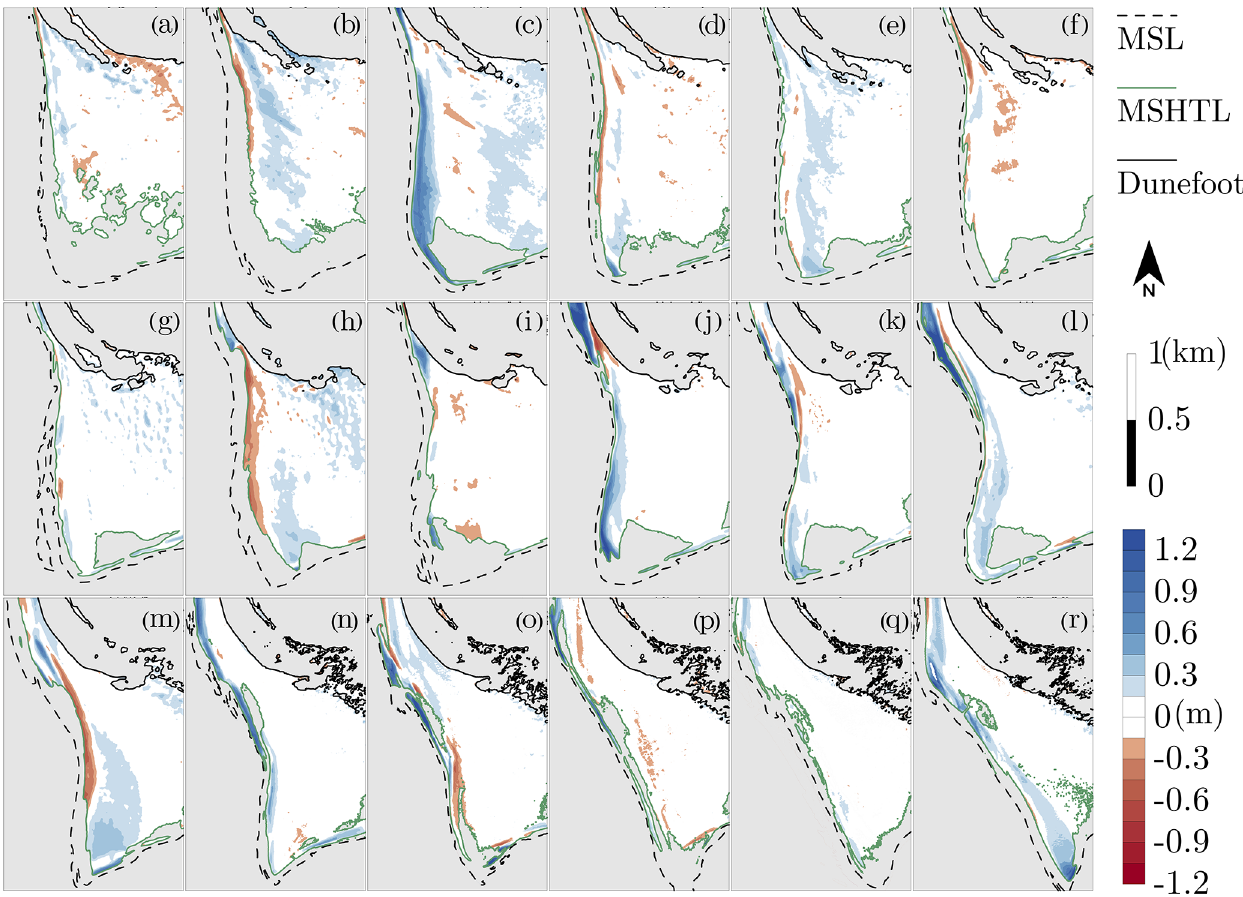
Figure 4. Difference maps for the periods between 1997 and 2017 focusing on the supratidal area. Letters refer to the specific years from which the subplots were calculated, as follows: (a) 1998–1997, (b) 1999–1998, (c) 2001–1999, (d) 2003–2001, (e) 2004–2003, (f) 2005– 2004, (g) 2006–2005, (h) 2007–2006, (i) 2008–2007, (j) 2009–2008, (k) 2010–2009, (l) 2011–2010, (m) 2012–2011, (n) 2013–2012, (o) 2014–2013, (p) 2015–2014, (q) 2016–2015, and (r) 2017–2016. Most plots show a 1-year difference, with exception of (c) and (d) , which represent the difference between 1999–2001 and 2001–2003, respectively, due to the absence of surveys in the years 2000 and 2002.